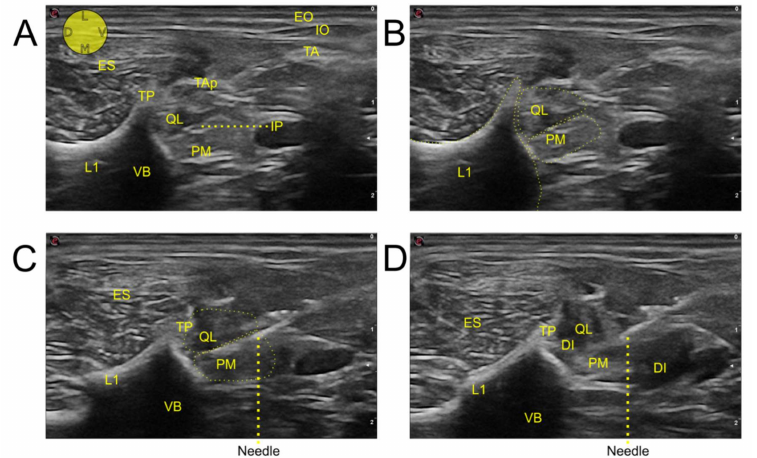
Figure 4. Ultrasound images of the modified approach to the QL block. ( A ) Sonoanatomy of the L1 region. ( B ) Schematic superimposition of the main anatomical structures. ( C ) Final position of the needle tip between the vertebral body and the psoas minor muscle. ( D ) Distribution of the injectate. L1, first lumbar vertebra; EO, external oblique muscle; IO, internal oblique muscle; TP, transverse process; TAp, transverse abdominal aponeurosis; TA, transverse abdominal muscle; ES, erector spinae muscles; QL, quadratus lumborum muscle; IP, interfascial plane; PM, psoas minor muscle; VB, vertebral body; DI, distribution of injectate; L, lateral; M, medial; D, dorsal; V,